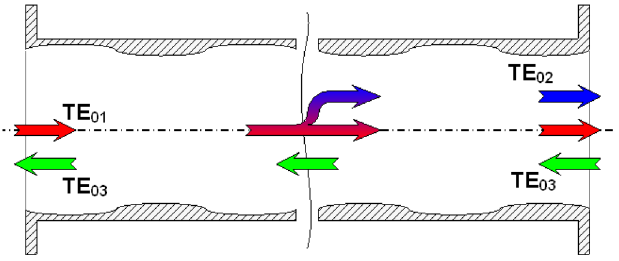
FIG. 10. (Color) TE